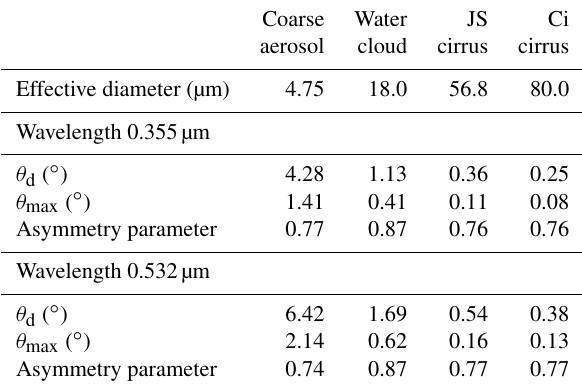
Table 1. Integral parameters of the phase functions; θ d is the Fraun- hofer diffraction angle, and θ max is the angle where the function p(θ) · sin (θ) takes the